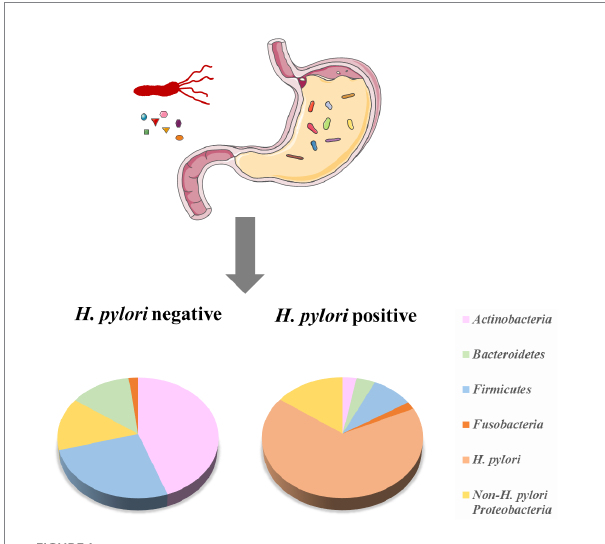
FIGURE 1 The composition of the human stomach microbiota and the effect of H. pylori on the microbiota. The microbiota of H. pylori ( − ) cases has higher diversity, with a higher relative abundance of Firmicutes and Actinobacteria . H. pylori (+) cases have a lower prevalence of Actinobacteria , Bacteroidetes , and Firmicutes , while increase Proteobacteria (adopted from Andersson et al., 2008 and Maldonado-Contreras et al.,